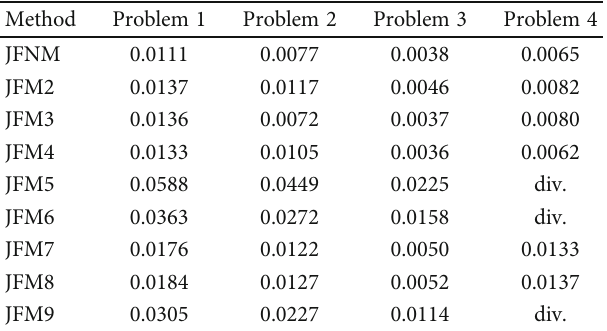
Table 7: Values of JFC1 for case n = 80 .